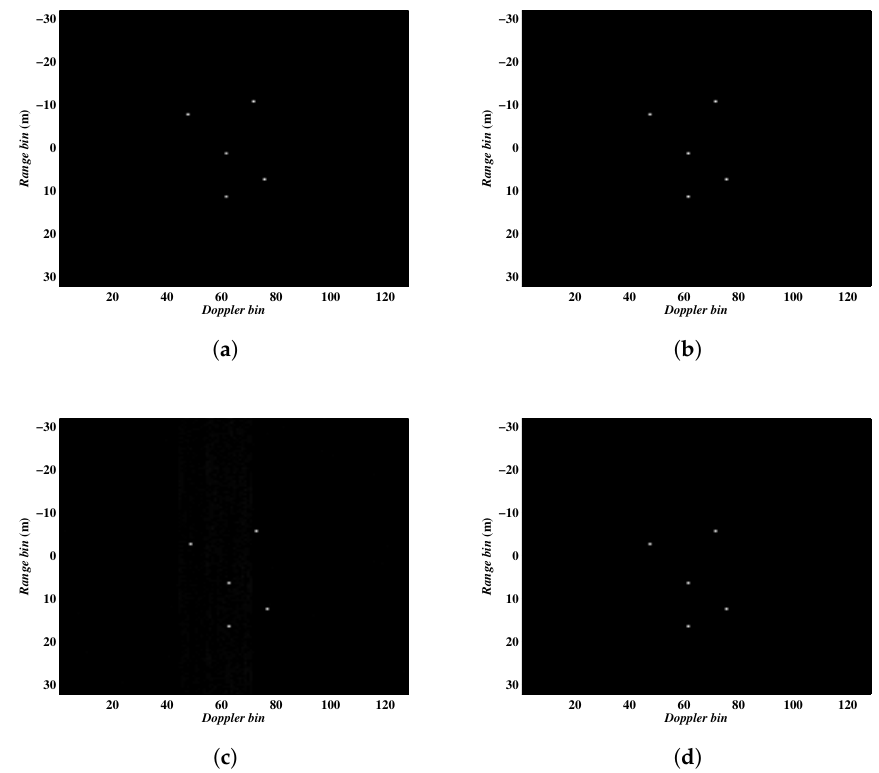
Figure 8. ISAR imaging results obtained by different methods. ( a – d ) corresponding to the imaging results by Algorithm 1, Algorithm 2, methods proposed in [14,15], respectively. Table 4. Entropies of the imaging results and CPU time of methods. Figure 8a Figure 8b Figure 8c Figure